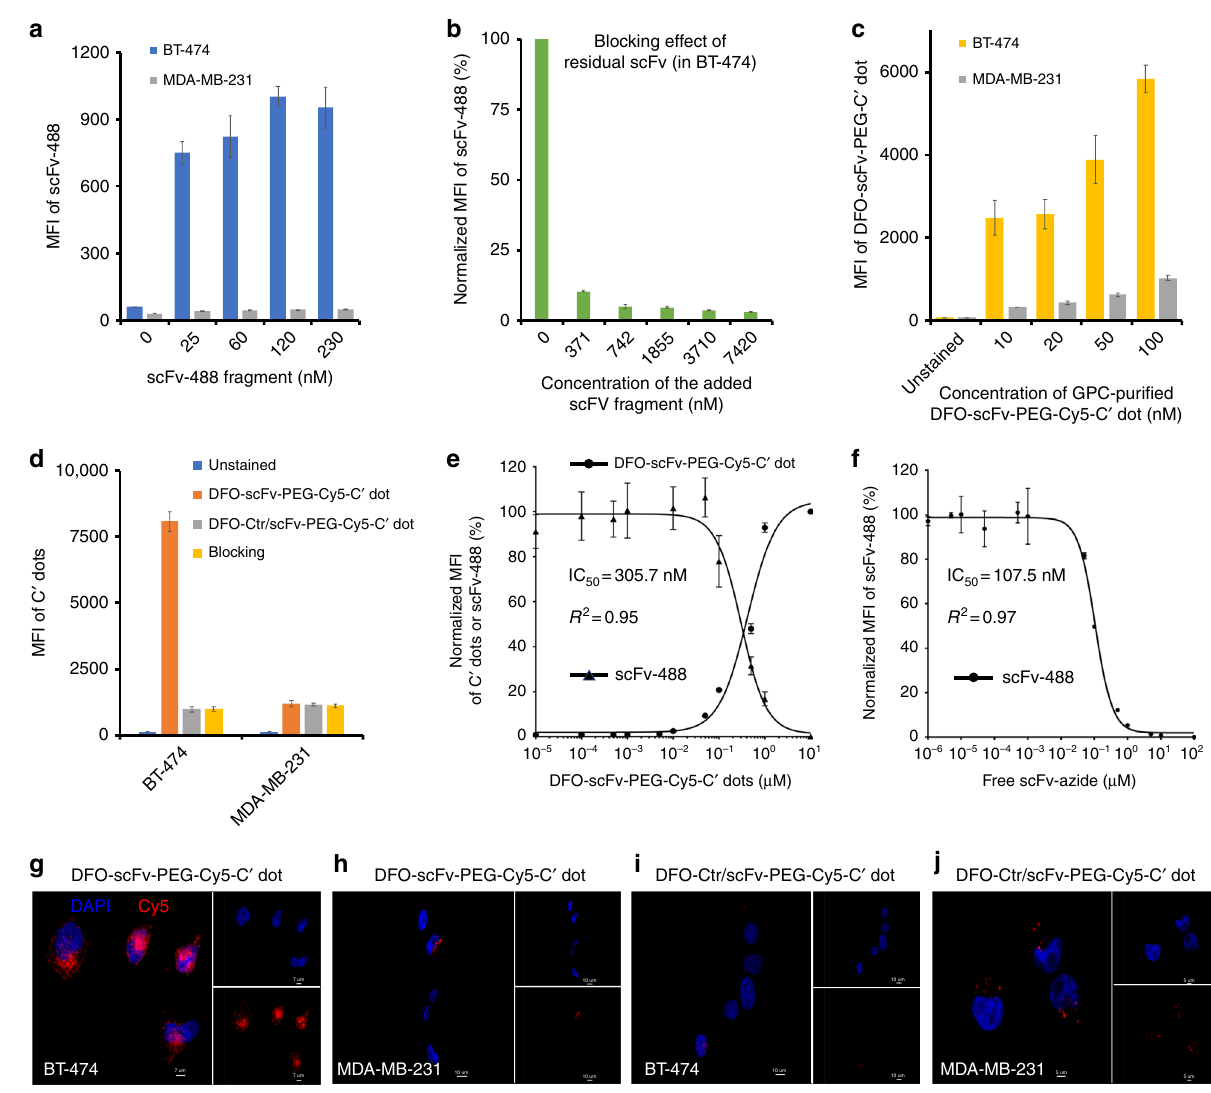
Fig. 2 In vitro HER2-speci fi c targeting and half maximal concentrations (IC 50 ) of free scFv and DFO-scFv-PEG-Cy5-C ’ dots using fl ow cytometry. a In vitro concentration-dependent HER2 targeting of scFv-488 in BT-474 and MDA-MB-231 cell lines. b Blocking of scFv-488 binding to HER2 receptors expressed on BT-474 cells as a function of scFv-azide concentration. c HER2-targeted uptake of GPC-puri fi ed DFO-scFv-PEG-Cy5-C ’ dots in BT-474 and MDA-MB- 231 cells as a function of particle concentration. All p values < 0.001. d HER2 targeting speci fi city of DFO-scFv-PEG-Cy5-C ’ dots (100 nM). DFO-Ctr/scFv- PEG-Cy5-C ’ dots (100 nM) were used as a particle control. For the blocking group, a 20-fold excess of free scFv-azide fragment was used. All p values < 0.001. e Concentration-dependent inhibition of scFv-488 binding to BT-474 cells by DFO-scFv-PEG-Cy5-C ’ dots. IC 50 = 305.7 nM. f Concentration- dependent inhibition of scFv-488 binding to BT-474 cells by free scFv-azide fragments. IC 50 = 107.5 nM. Each data point represents the mean ± s.d. of three replicates. Confocal microscopy imaging of DFO-scFv-PEG-Cy5-C ’ dots (100 nM) in g BT-474 (scale bar: 7 μ m) and h MDA-MB-231 (scale bar: 10 μ m), and DFO-Ctr/scFv-PEG-Cy5-C ’ dots (100 nM) in i BT-474 (scale bar: 10 μ m) and j MDA-MB-231 (scale bar: 5 μ m). Blue and red colors represent DAPI and Cy5, respectively. Insets in g – j show the corresponding DAPI and Cy5